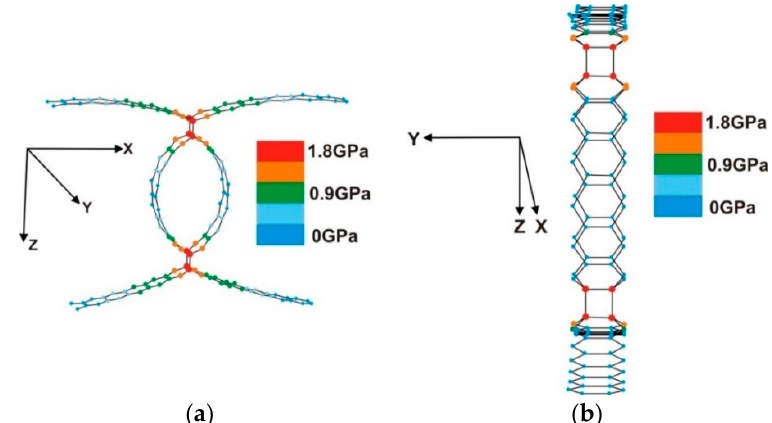
Figure 5. The local stress distribution of the atomic network of the central fragment of a monolayer graphene–CNT composite film with CNT (12,0) and an inter-tube distance of 12 hexagons when bending in the direction perpendicular to ( a ) CNTs and along the ( b ) CNT axis.